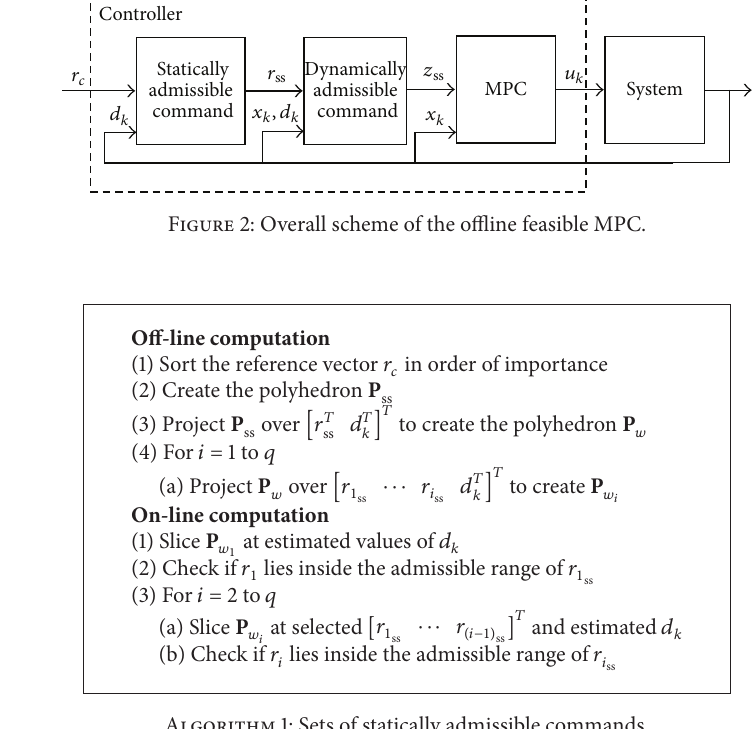
Algorithm 1: Sets of statically admissible